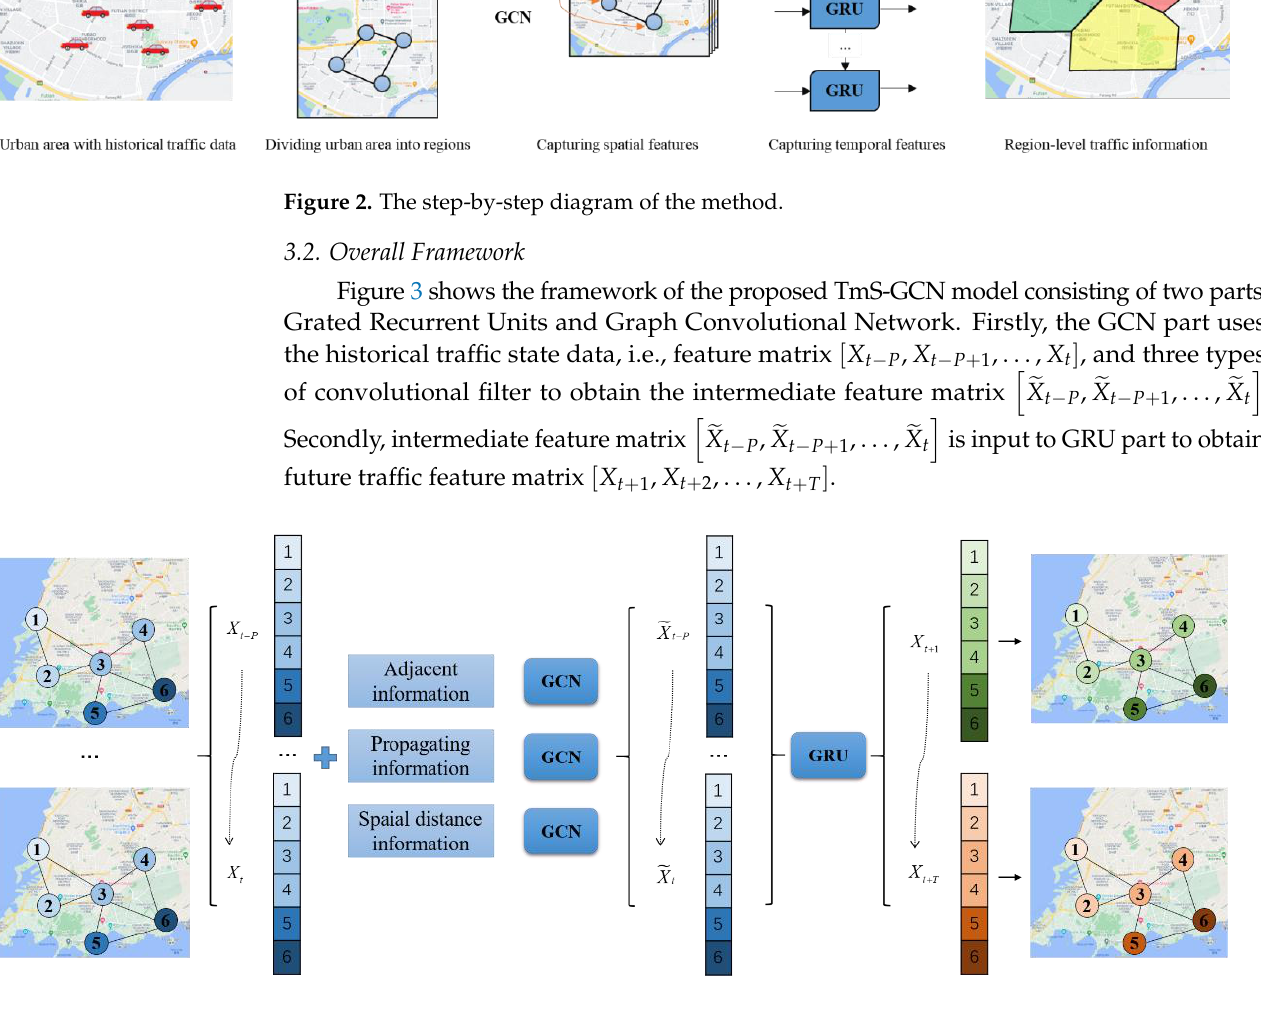
Figure 3. Overall framework of TmS-GCN.